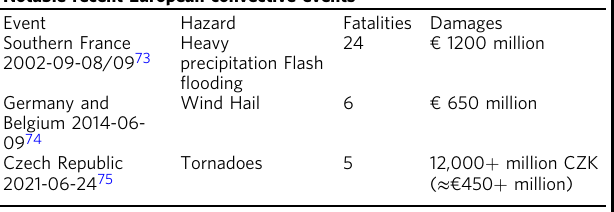
Table 1 Examples of notable European extreme weather events that could be attributable to MCSs and organised convective